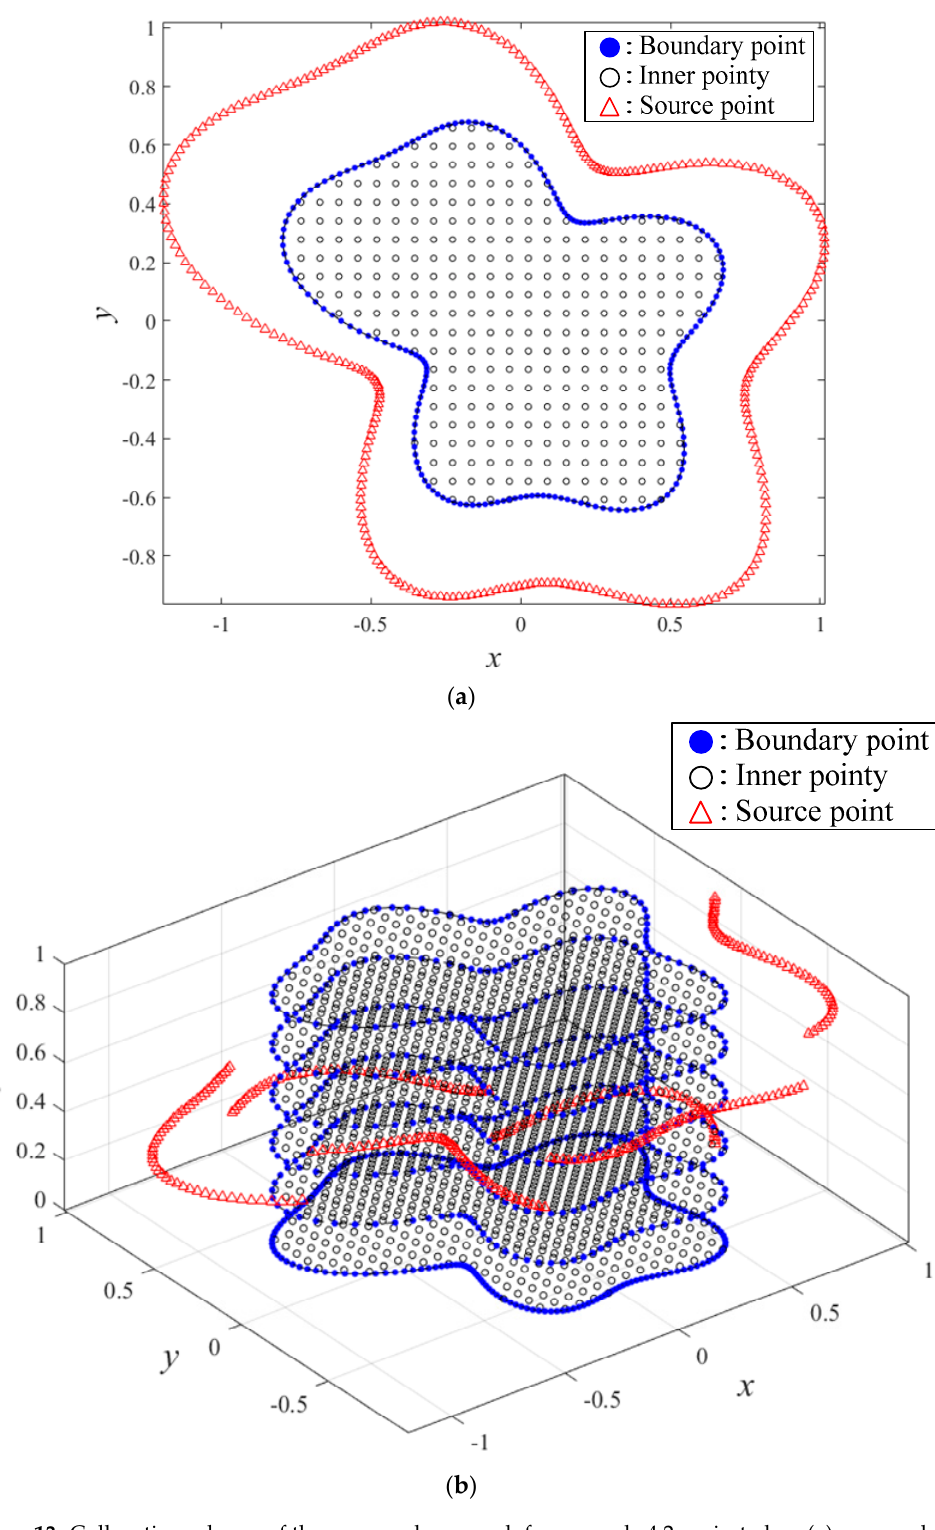
Figure 13. Collocation scheme of the proposed approach for example 4.2 projected on ( a ) an x – y plane and ( b ) space–time